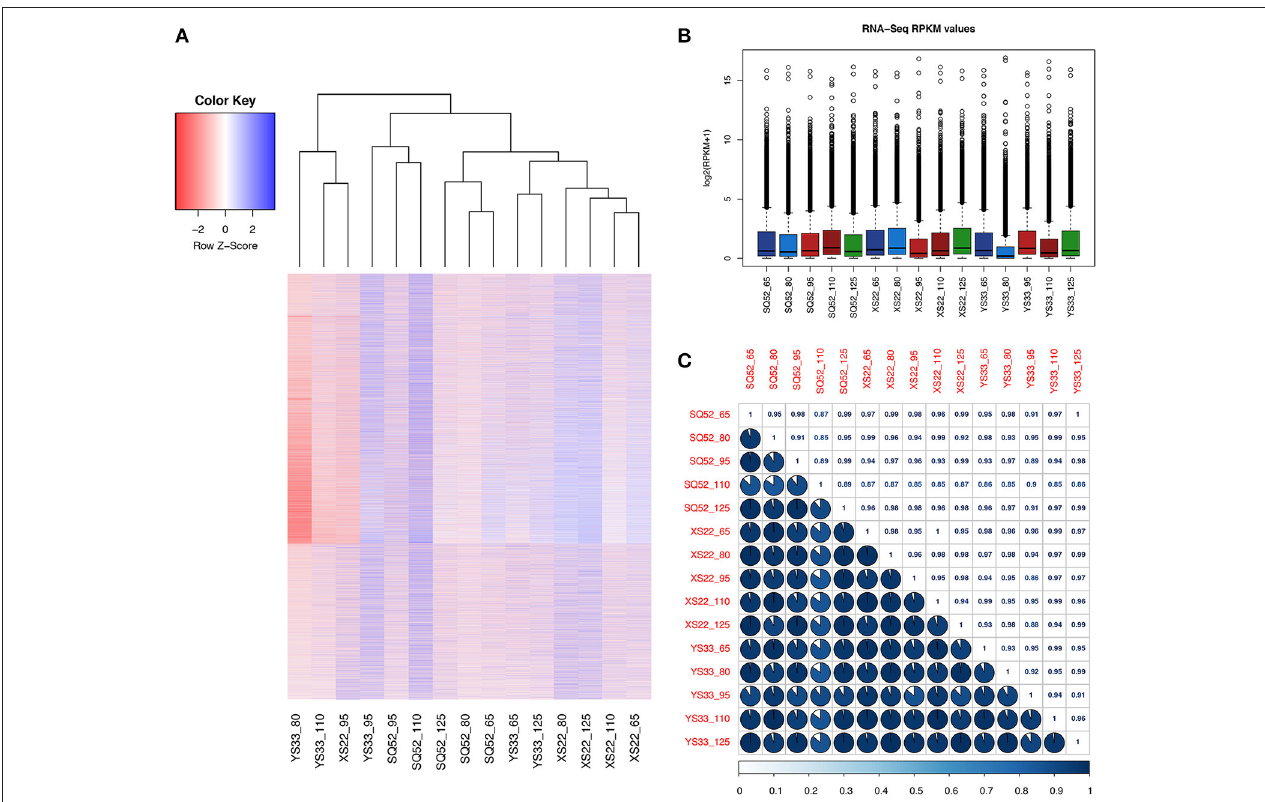
FIGURE 4 | Comparison of the transcriptomes among the tested SR samples. (A) Heatmap plotting and cluster analysis of 15 SR databases based on the expression pattern and abundance of unigenes; (B) Box plot showing the RPKM distribution of unigenes in the 15 samples; (C) Correlation analysis among samples. The correlation matrix was performed by comparing the values of the whole transcriptome in 15 samples, and Pearson’s correlation coefficient among samples was analyzed using R scripts.